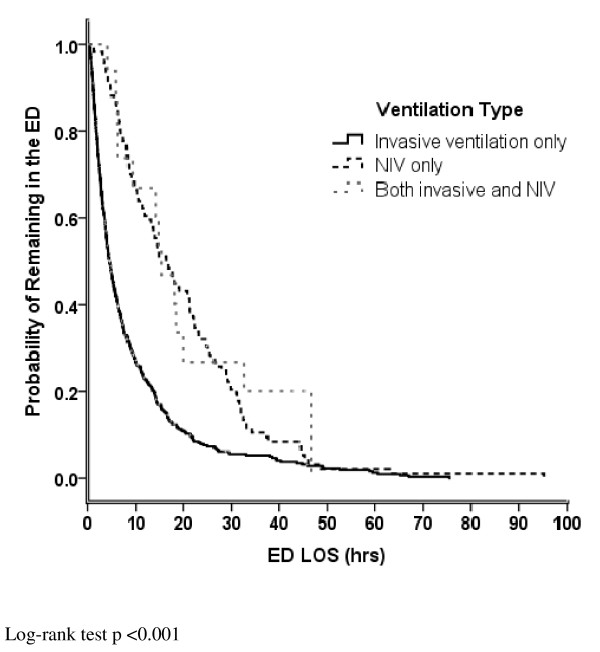
Kaplan-Meier Estimated Probability of Remaining in the ED. Legend:___ = invasive ventilation only ---- = non-invasive ventilation only, ---- = both invasive and non-invasive ventilation.